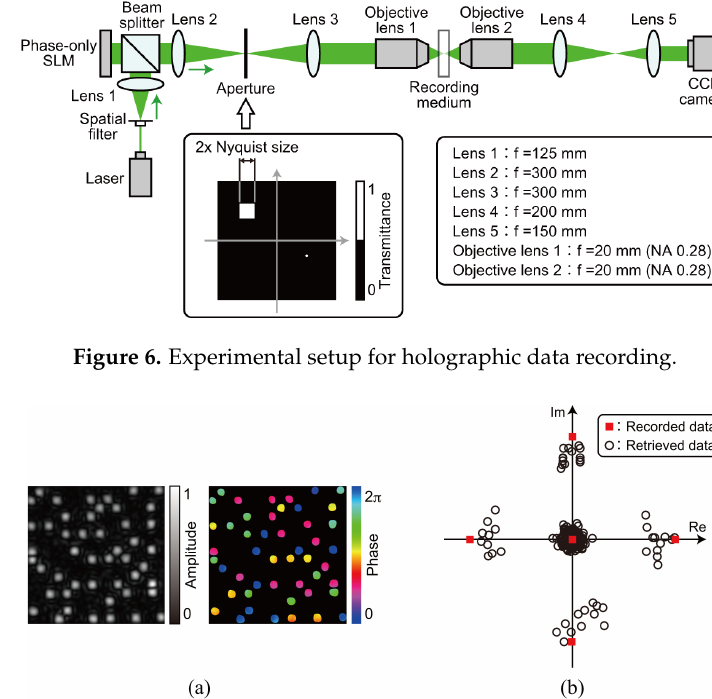
Figure 7. Retrieved complex amplitude data page 1. ( a ) complex amplitude distribution; ( b ) averaged complex amplitude values on a complex